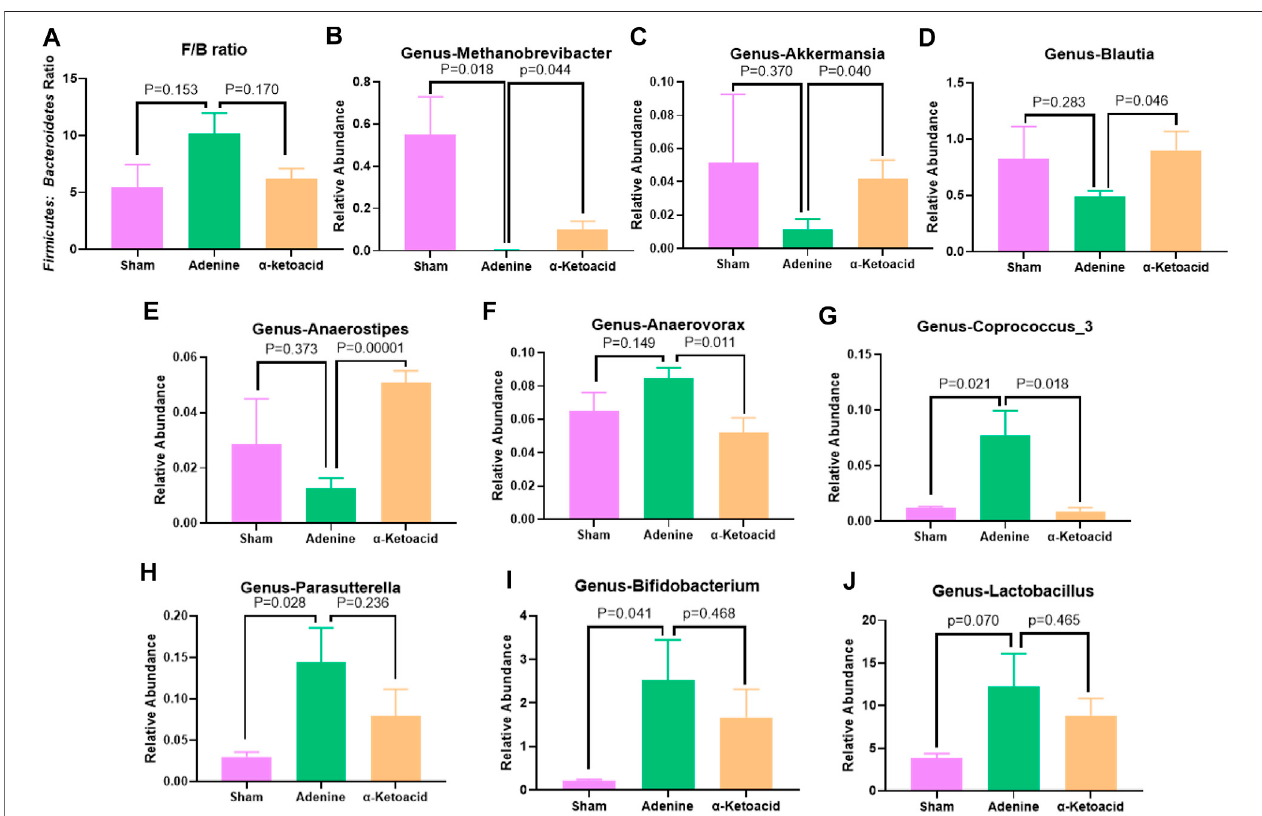
FIGURE4| The relative abundances ofdifferential bacteriainthe gutmicrobiota at genus levels. (A) Firmicutes to Bacteroidetes ratio. (B) Methanobrevibacter. (C) Akkermansia. (D) Blautia. (E) Anaerositipes. (F) Anaerovorax. (G) Coprococcus_3. (H) Parasutterella. (K) Bi fi dobacterium. (I) Lactobacillus. Data are presented as the means ± standard error of the mean. n (cid:1) 8 rats per group. A value of p < 0.05 was considered statistically signi fi cant by Welch ’ s t test.